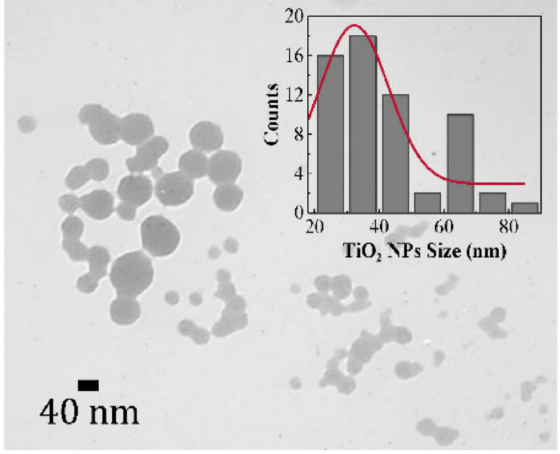
Figure 4. TEM image of PMZE0.6T glass